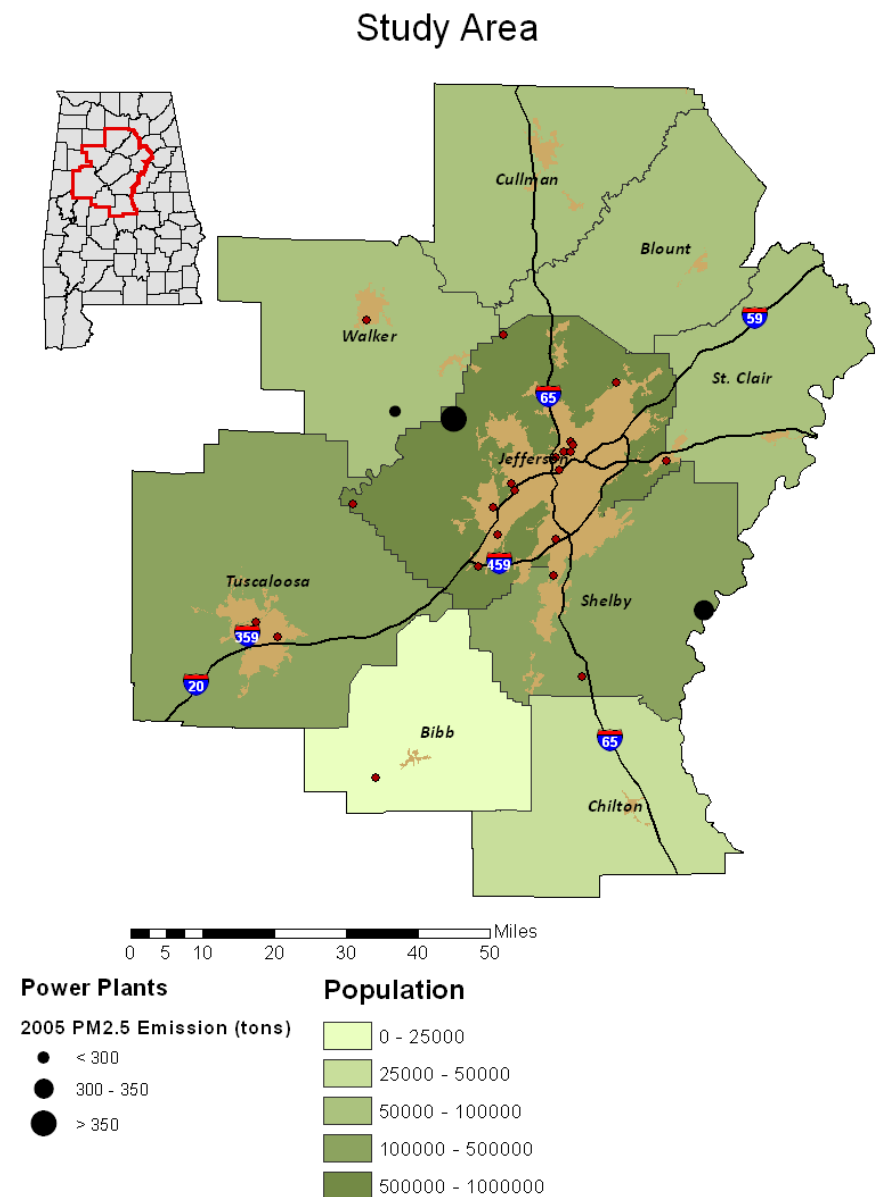
Figure 1. Overview of the nine-county study area along with interstate highways and urban areas (tan). Particulate matter (PM) monitoring stations used in this study are shown in red and three major power plants in black